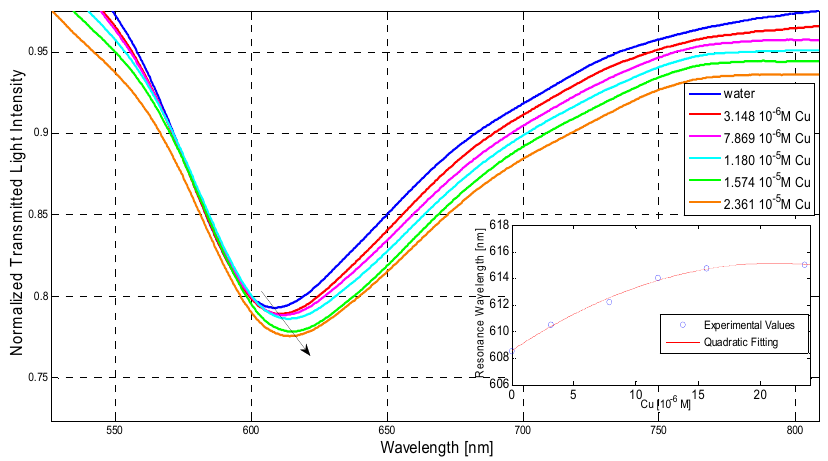
Figure 1. SPR transmission spectra, normalized to the air spectrum, for different analyte concentrations [Cu(II) 3.1 × 10 − 6 M–2.4 × 10 − 5 M]. Inset: Plasmon resonance wavelength as a function of analyte concentrations, with the corresponding fitting curve.